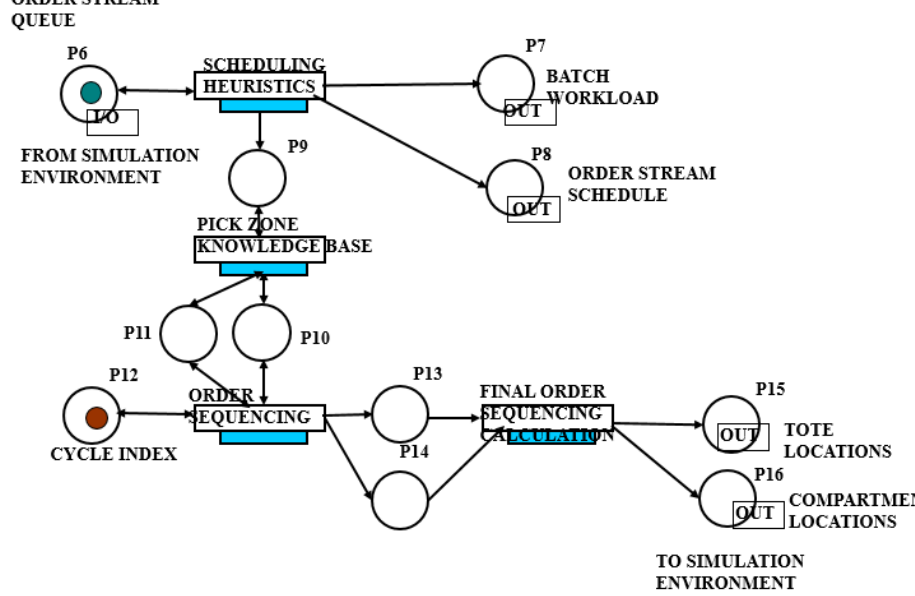
Figure 3. The implemented hierarchical CTPN model of the Scheduling Agent substitution transition. Table 3. Basic color set declarations of the CTPN system model.